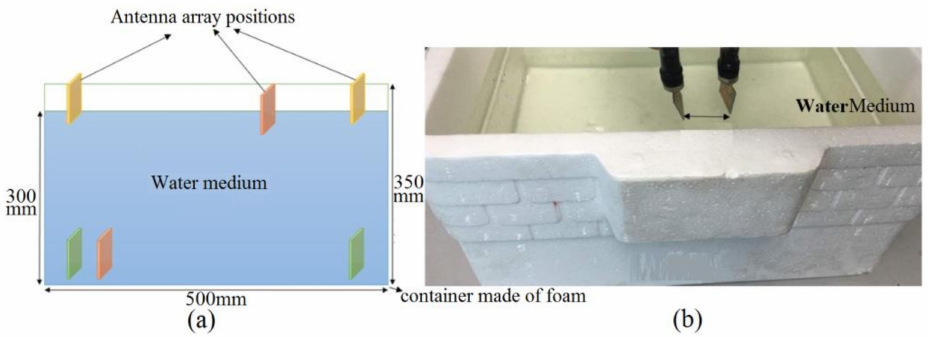
Figure 2. The system configuration in both simulation ( a ) and ( b ) measurement setups.